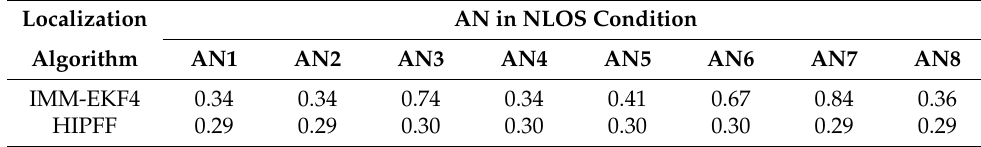
Table 1. RTAMS position errors (unit: meter) under NLOS conditions.